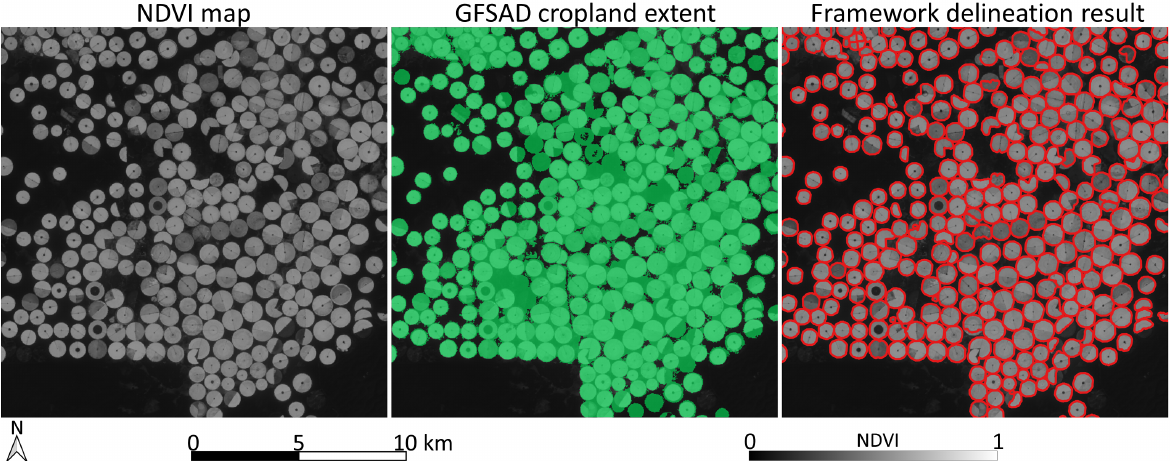
Figure A2. An example of a maximum annual NDVI map associated with the Global Food Security- support Analysis Data (GFSAD) cropland extent map (30 m spatial resolution) and the framework delineation